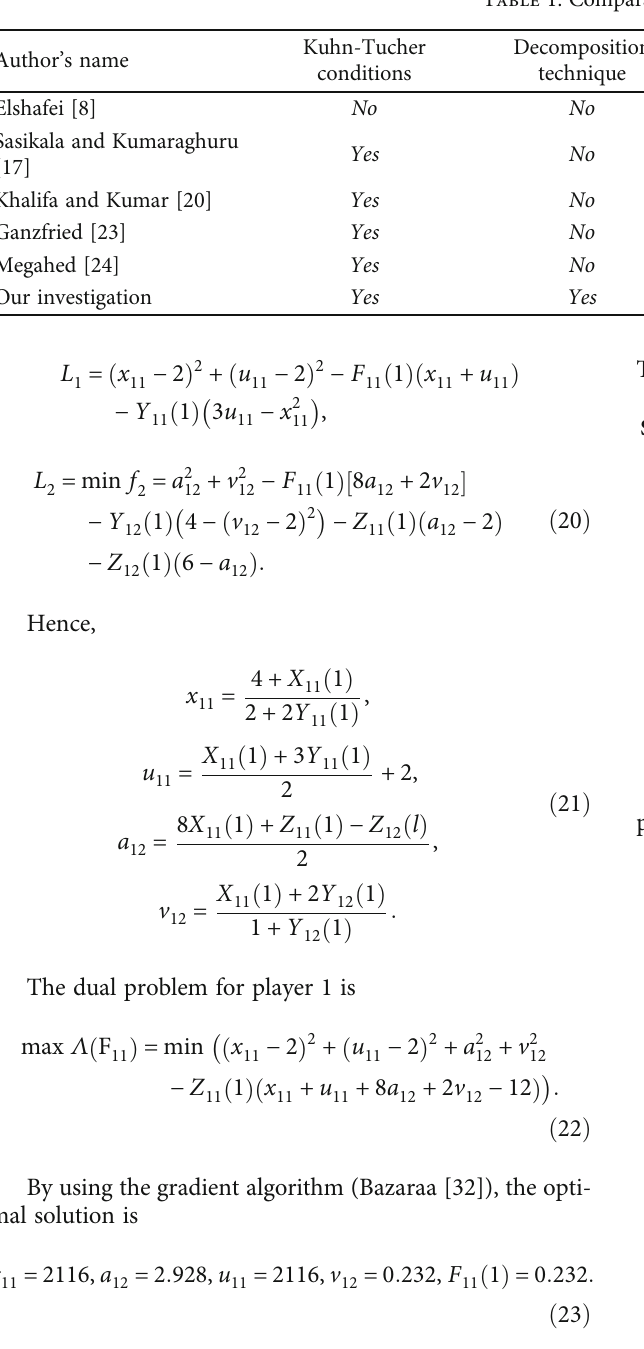
Table 1: Comparative